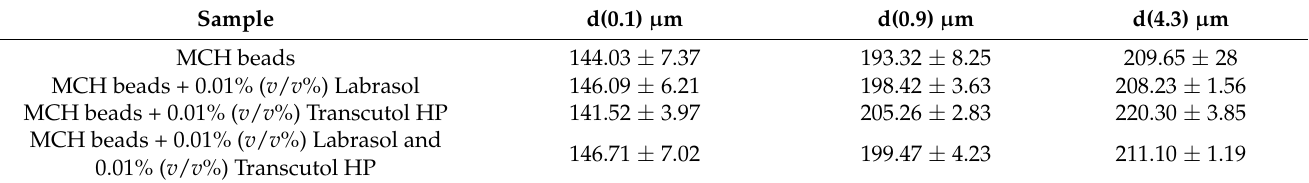
Table 2. Results of laser diffraction particle size distribution.